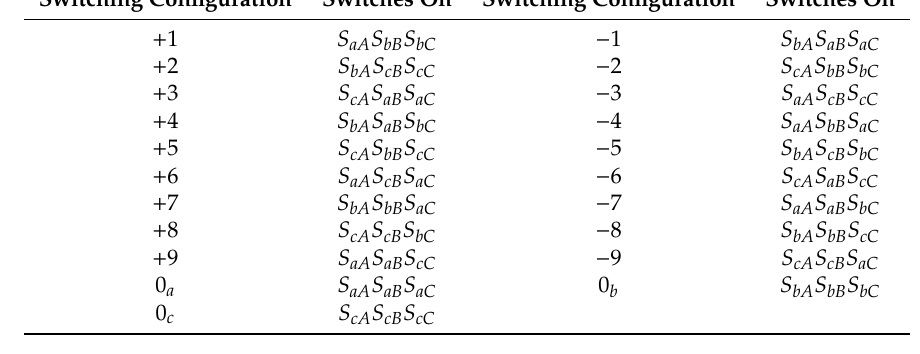
 → and ( b ) v o and ( b )